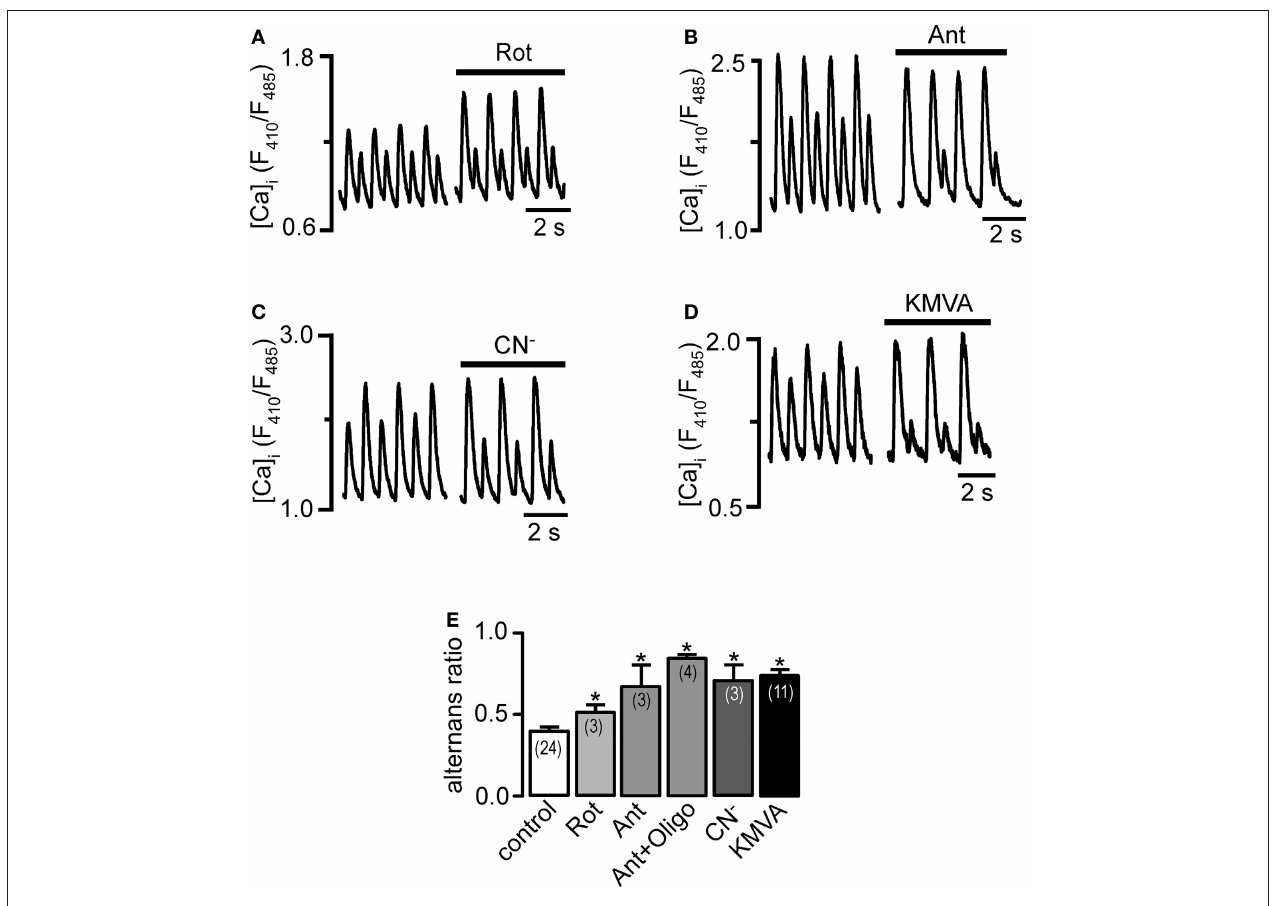
Figure 2 | effects of inhibition of mitochondrial respiration and metabolism on Ca alternans. (A) Rotenone (Rot, 5 μM), (B) antimycin (Ant, 5 μg/ml), (C) cyanide (CN − , 1 mM), and (D) KMVA (5 mM) enhanced